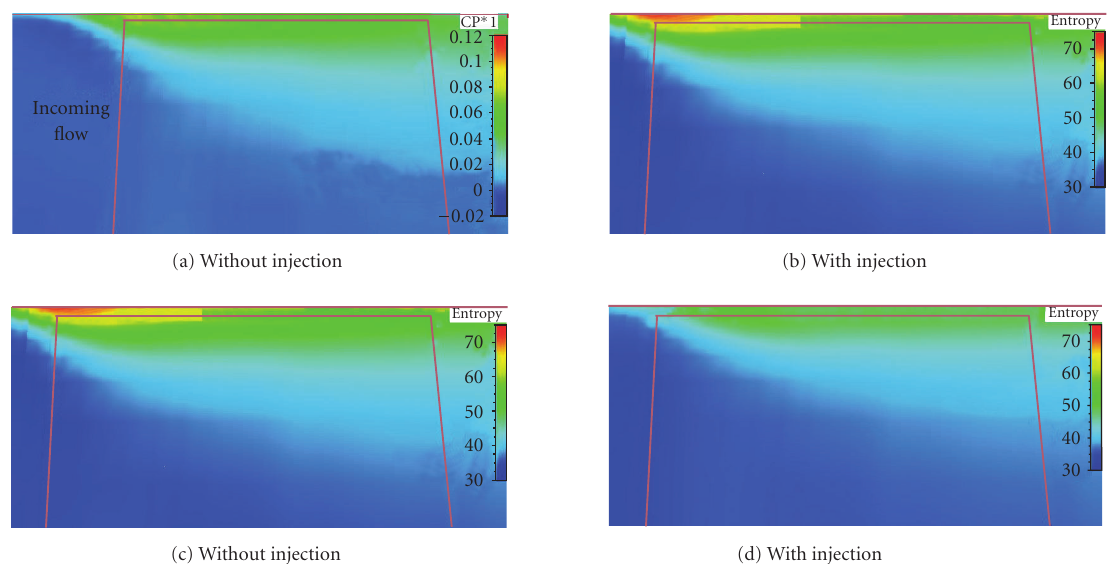
Figure 12: Circumferentially averaged entropy and total pressure loss coe ffi cient contours near blade tip.